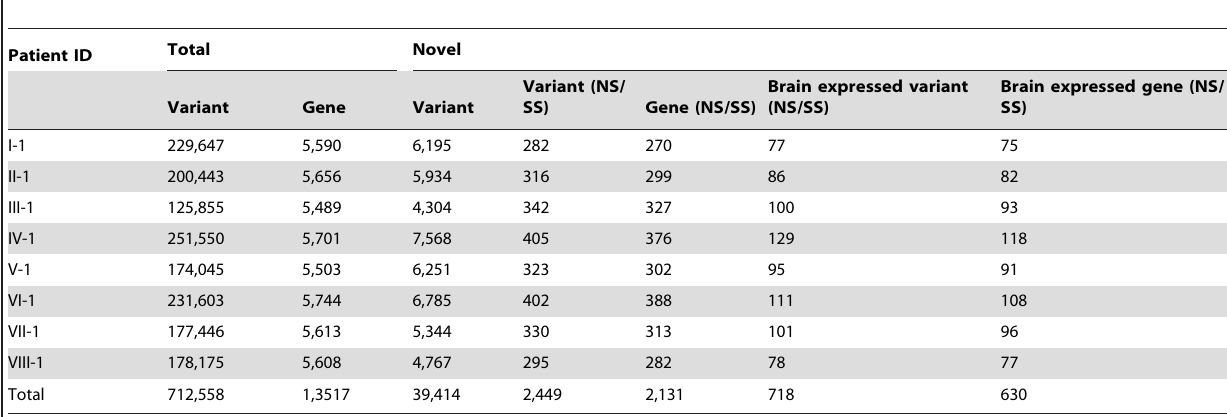
Table 1. Distribution of novel non-synonymous single nucleotide polymorphisms including brain-expressed genes in eight patients with AHC.